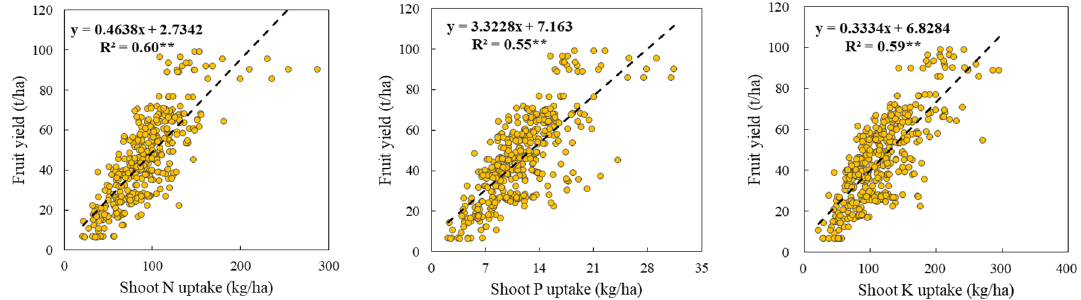
Figure 1. Relationships between observed fruit yield and N, P, and K uptake in the shoot dry matter at all sites in watermelon production areas in China. Dotted line represents the linear regression line. Two asterisks (**) represent the significance at the 0.01 level.